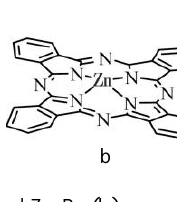
Fig. 1. Chemical structures of Mg-Pc (a) and Zn-Pc (b)